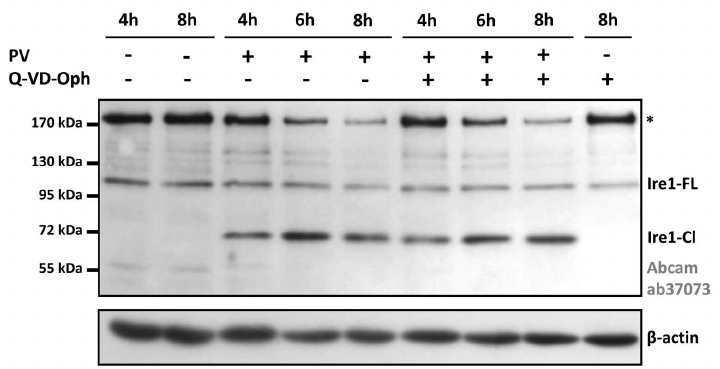
Figure 3. Ire1 proteolytic cleavage in the PV-infected HeLa cells is not affected by the pan-caspase inhibitor Q-VD-Oph. HeLa cells were infected with PV in the absence or presence of 20 µ M Q-VD- Oph. After the time indicated, cells were lysed and analyzed by Western blotting with polyclonal anti-Ire1 antibodies (Abcam #ab37073). Asterisks denote the same as in Figure